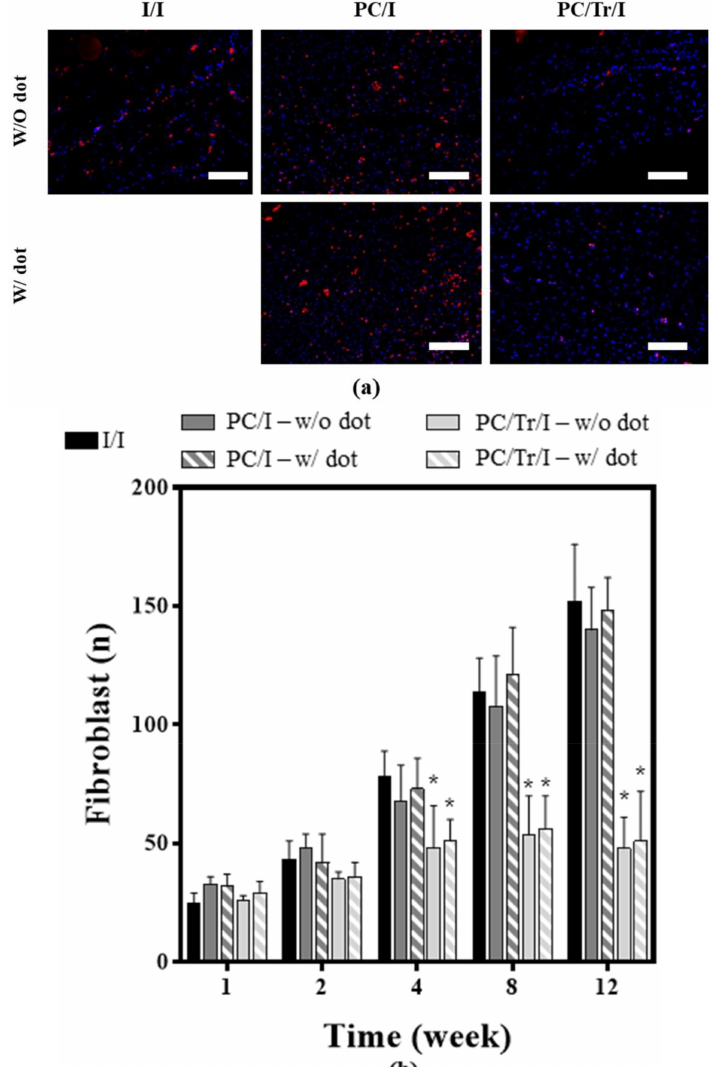
Figure 9. Evaluation of fibroblast number 12 weeks after sample implantation. ( a ) Representative IF-stained images of fibroblasts at 12 weeks. Scale bars are 200 µ m. ( b ) Profiles of fibroblast number. * Statistically significant difference from the I/I ( p < 0.05). Error bars are the standard